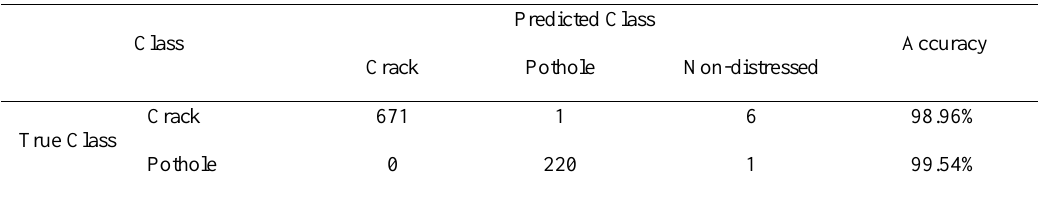
Table 4. Confusion Matrix of